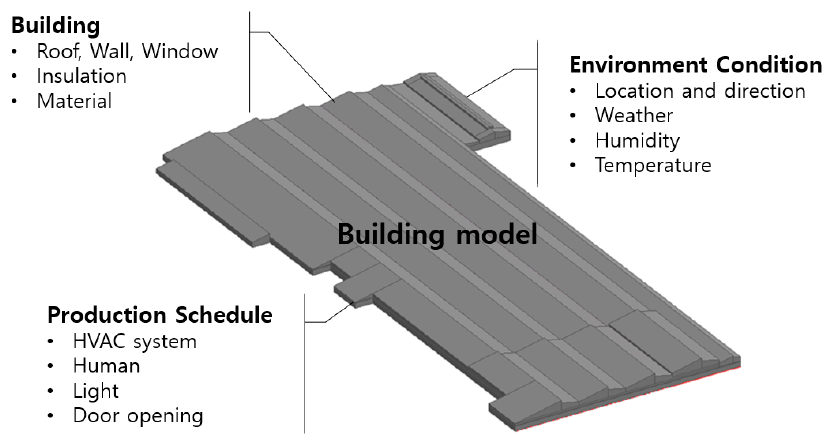
Figure 5. Building models with analysis condition of building energy simulation models.